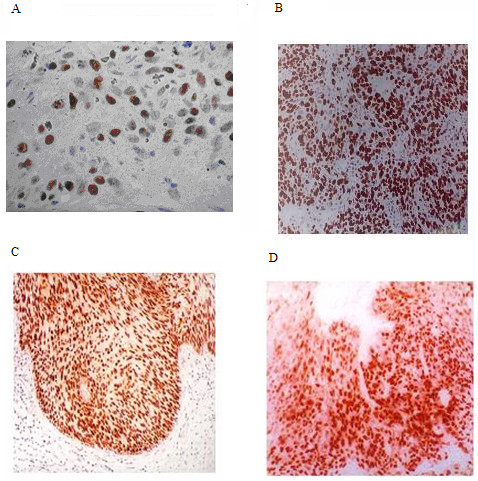
Cases of invasive squamous cell carcinoma showing a) strong nuclear immunostaining for p53, b) diffuse nuclear staining for mdm2, c) positive nuclear immunostaining for p21WAF and, d) positive immunostaining for ki-67.